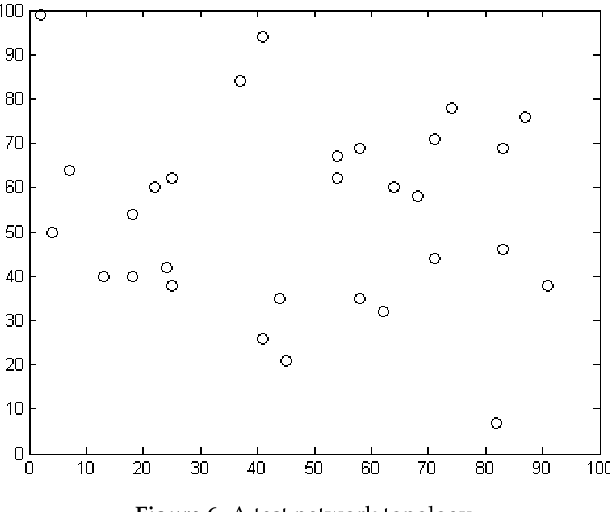
Figure 6. A test network topology.